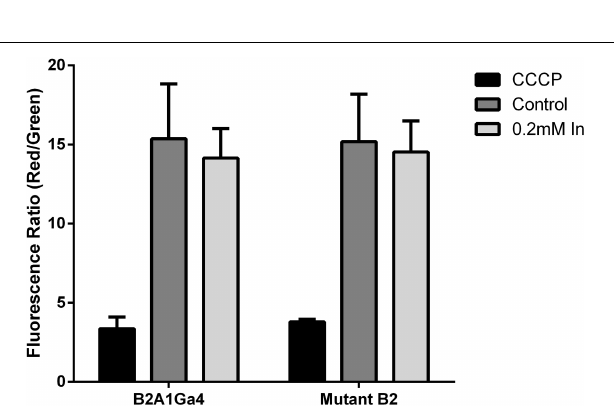
FIGURE 7 | Membrane potential ( (cid:49) ψ ) of both strains (B2A1Ga4 and mutant B2) using the probe JC-1 red/green dye, represented as fluorescence ratio red (595 nm)/green (530 nm) at different conditions: CCCP, control (without metal), and 0.2 mM In. Data shown are the mean values ( ± standard deviations) obtained from two independent